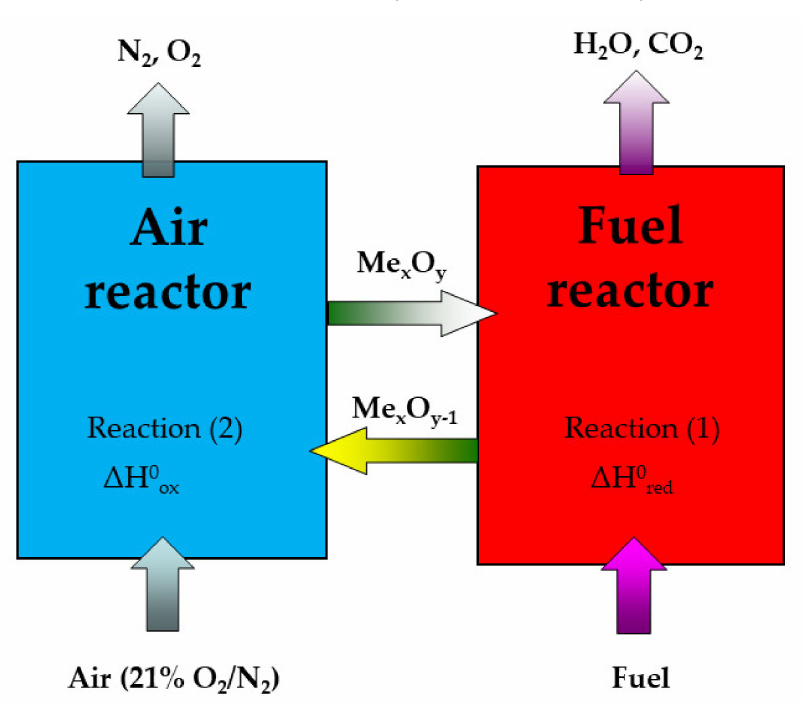
Figure 1. Scheme for the CLC process, depicting two reactors with circulating oxygen